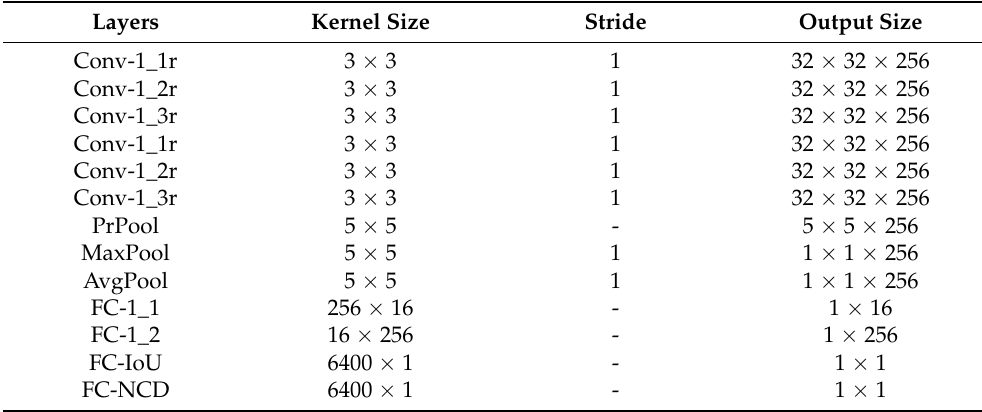
Table 3. Parameter settings of DIoU discriminative